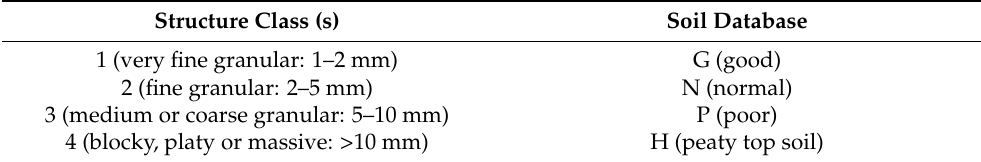
Table 3. Soil permeability classes and saturated hydraulic conductivity ranges estimated from major soil textural